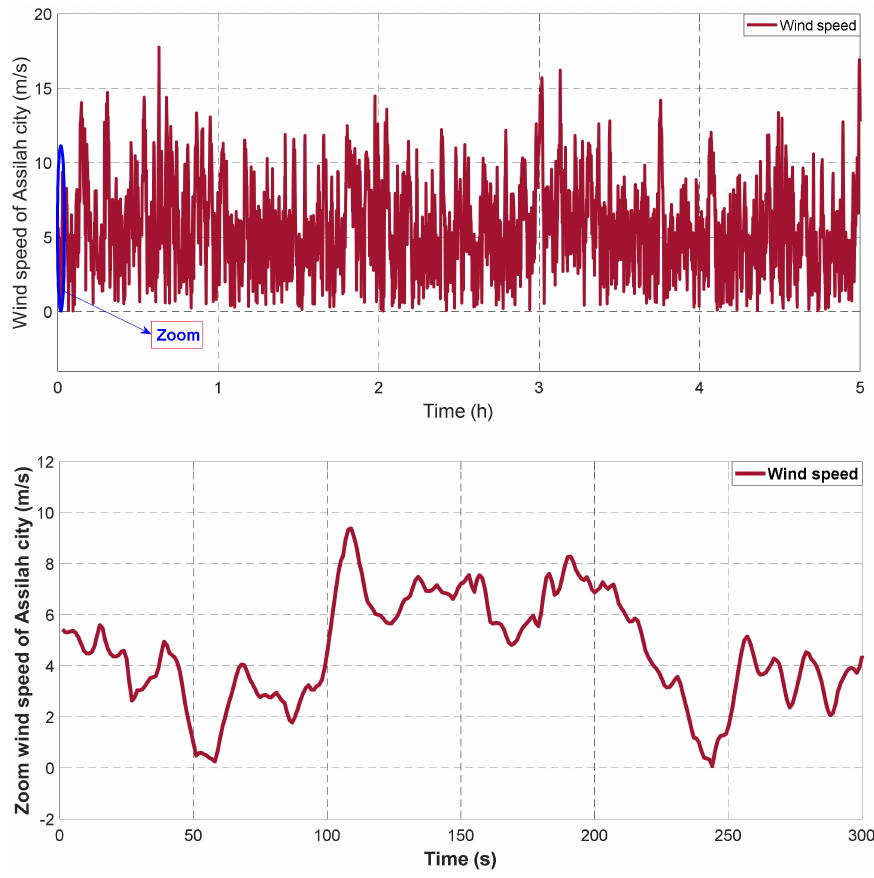
Figure 16. Wind speed profile of Assilah, Morocco.